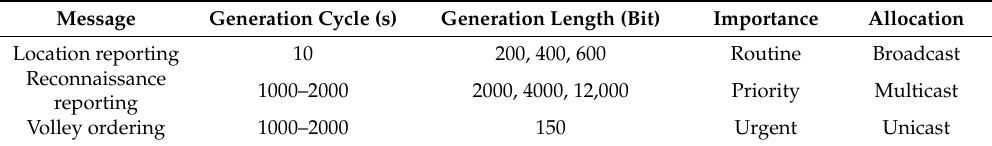
Table 5. Examples of message variables in CNR networks based on infantry networks.